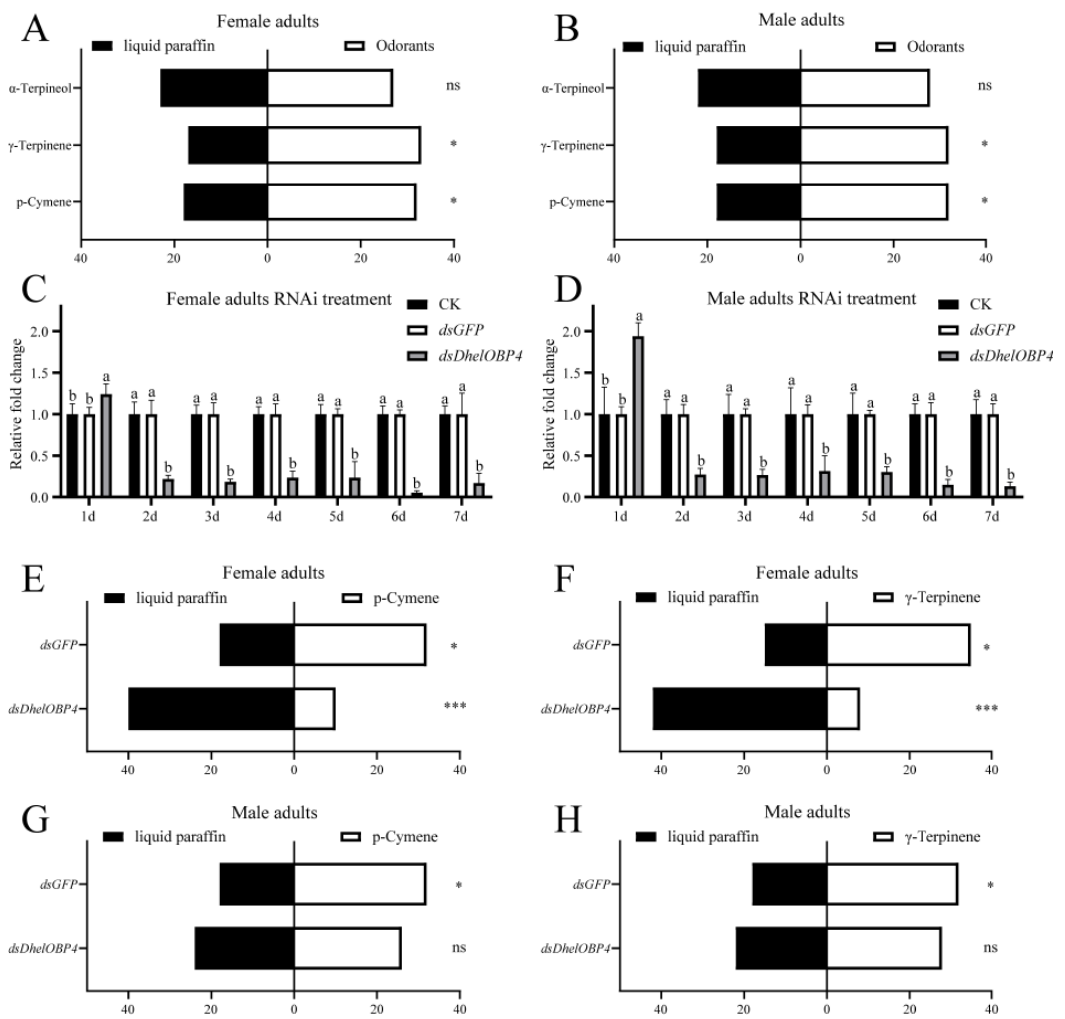
Figure 7. Y-tube olfactometer bioassays and RNAi-mediated bioassays. Same letters, no significant difference; Different letters, significant difference. ns indicates no significant difference; *, 0.01 < p < 0.05; ***, p < 0.001. ( A , B ) Behavioral response of D. helophoroides to α -terpineol, γ -terpinene, and p -cymene. α -Terpineol showed no behavioral effects on female ( p = 0.5716, chi-square = 0.3200) and male ( p = 0.3961, chi-square = 0.7200) adults. γ -Terpinene and p -cymene showed attractive effects on fe- male ( p = 0.0237, 0.0477 and chi-square = 5.1200, 3.9200, respectively) and male ( p = 0.0477, 0.0477 and chi-square = 3.9200, 3.9200, respectively) adults. ( C , D ) Transcript levels of DhelOBP4 post-RNAi